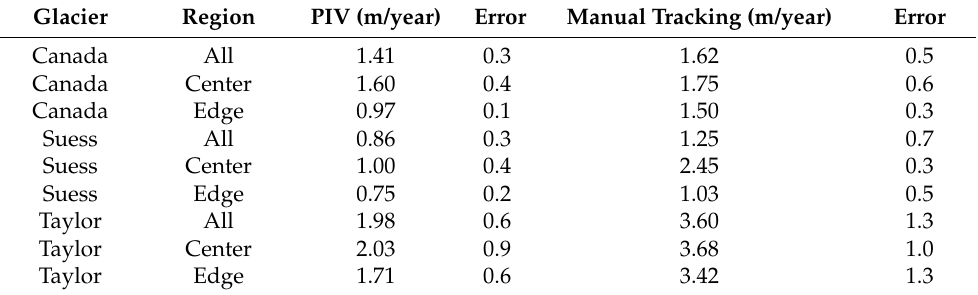
Figure 4. Canada Glacier PIV Results. Surface roughness (average 0.4 m) of Canada Glacier is overlaid by PIV results, averaged over 200 m × 200 m cells. Table 1. Results for Canada, Suess, and Taylor Glaciers in Taylor Valley. All refers to the entire glacier surface that was used in the PIV analysis. Edge refers to the 200 m of glacier nearest to the glacier edge and center refers to everything other than the edge.